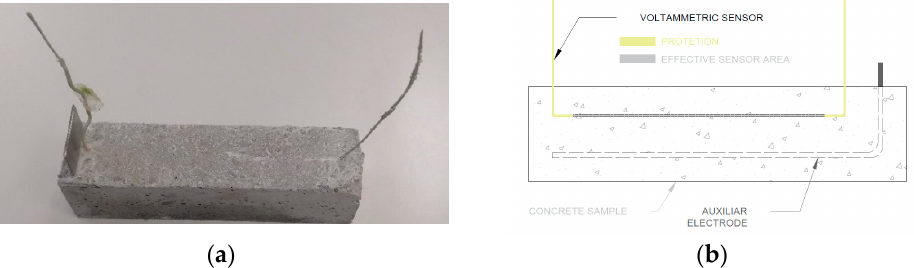
Figure 1. ( a ) Picture of a sample with an embedded SS sensor; ( b ) Outline of the configuration of the SS sensors embedded in a concrete sample. in a concrete